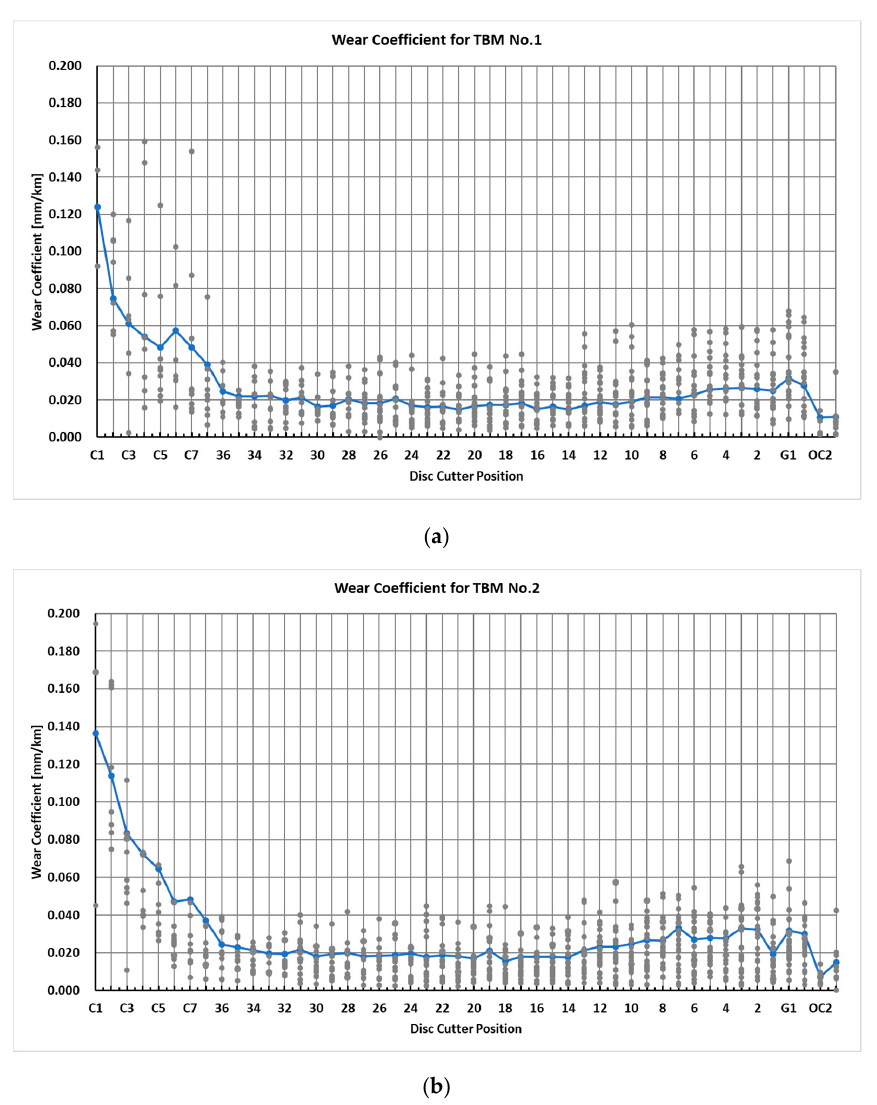
Figure 8. Wear coefficient of disc cutters with respect to position: ( a ) TBM No. 1; ( b ) TBM No. 2. Figure 8. Wear coe ffi cient of disc cutters with respect to position: ( a ) TBM No. 1; ( b ) TBM No.